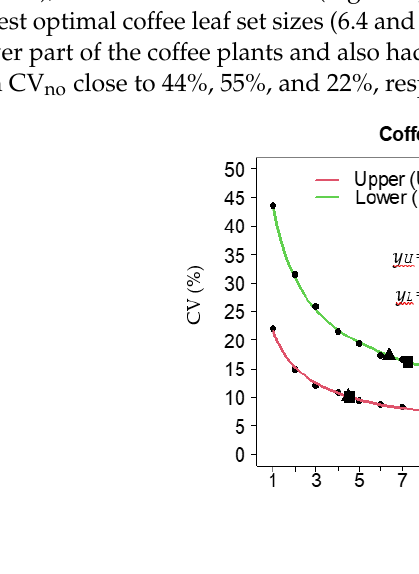
Figure 2. Coefficients of variation (CVs) as a function of the optimal sample size for spray deposition on the leaves for fine ( a ) and coarse ( b ) droplet classes and two parts of the plants, using two statistical models. Sample size in sets of 10 leaves; Parameters a and b significant ( p < 0.001) in all regressions; Exp: exponential model; SA: spatial autocorrelation model.